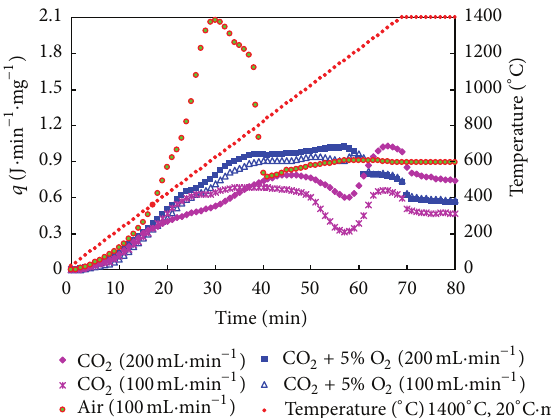
Figure 6: DTA curves of different gas flow rates and O 2 concentra- tions in flow